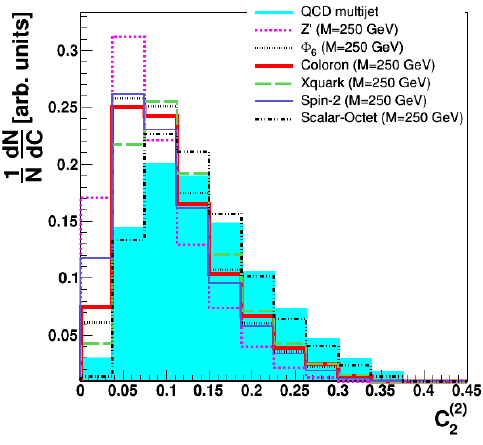
Figure 2 . The double ratio distributions C (2)